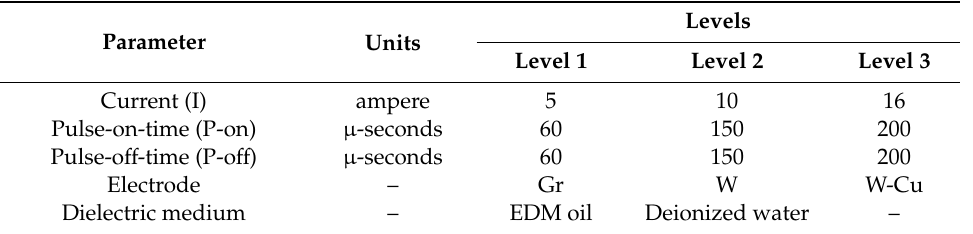
Table 2. Parameters descriptions and